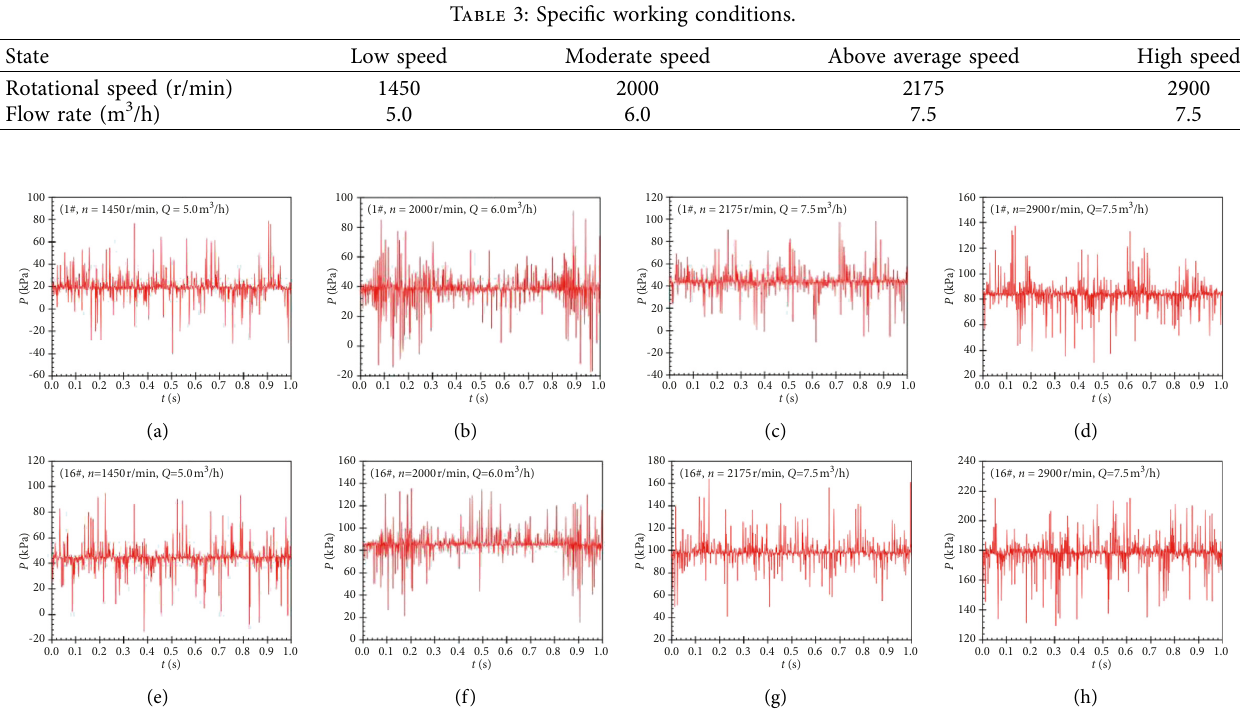
Figure 7: Variation characteristics of the instantaneous pressure at front wall of the volute casing. Table 4: Pressure fluctuation of pressure measurement point on the front wall of the volute